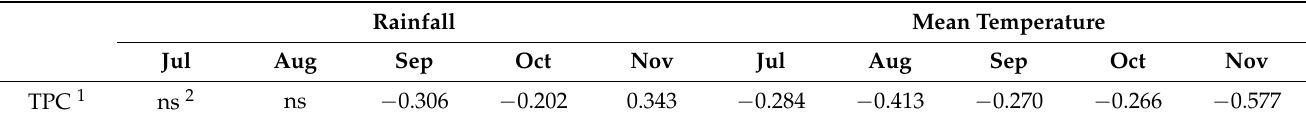
Table 2. Correlation factors of virgin olive oil phenol concentration and microclimate parameters (rainfall and mean temperature; Figure 1) in the period of olives’ intensive growth and